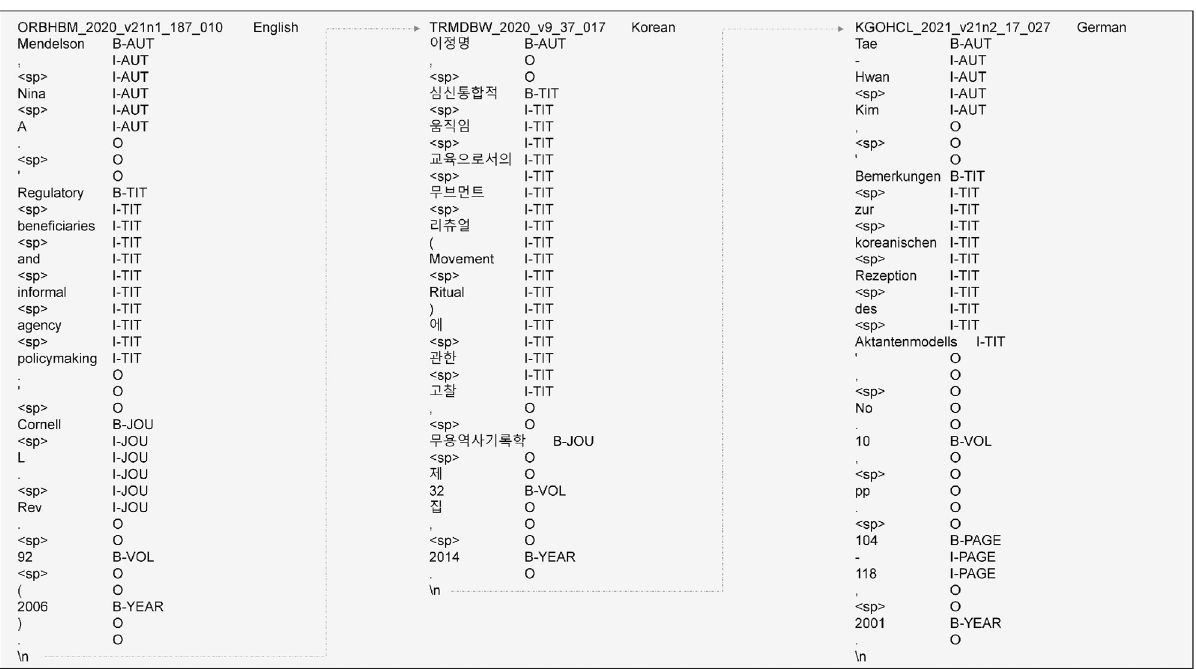
Fig 7. Sample of the corpus used for extracting metadata from multilingual journal references. The first column represents the tokens corresponding to the reference string and the second column represents the IOB tags corresponding to the tokens. Tokens and IOB labels were separated by